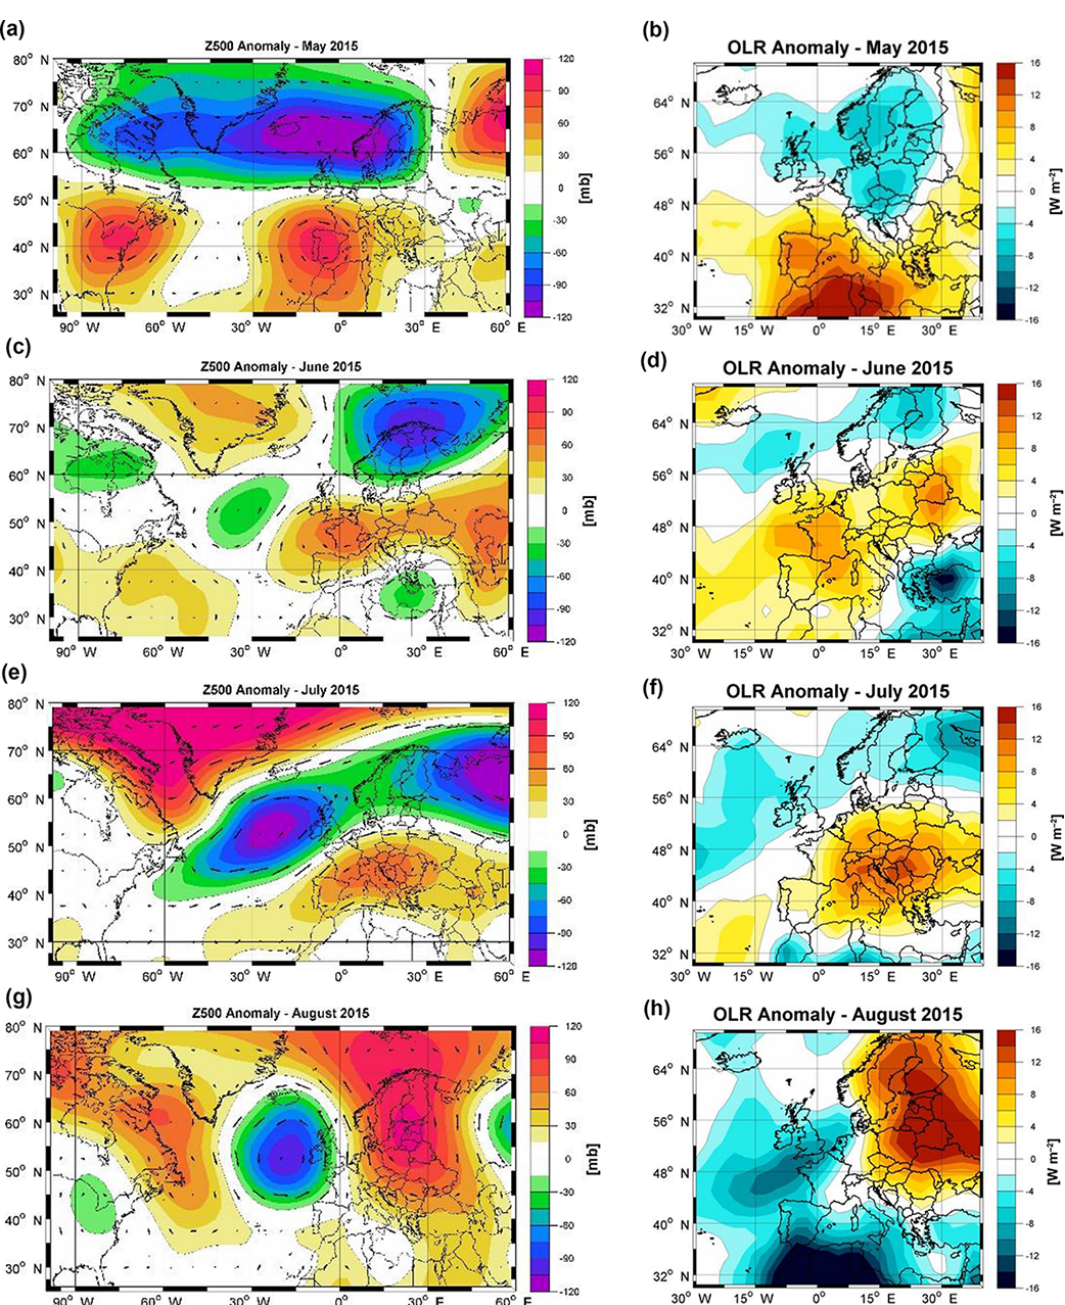
Figure 6. Monthly Z500 anomalies (left column) and OLR anomalies (right column). (a) and (b) : May 2015. (c) and (d) : June 2015. (e) and (f) : July 2015. (g) and (h) : August 2015. The anomalies for Z500 and ORL are computed relative to the period 1971–2000.